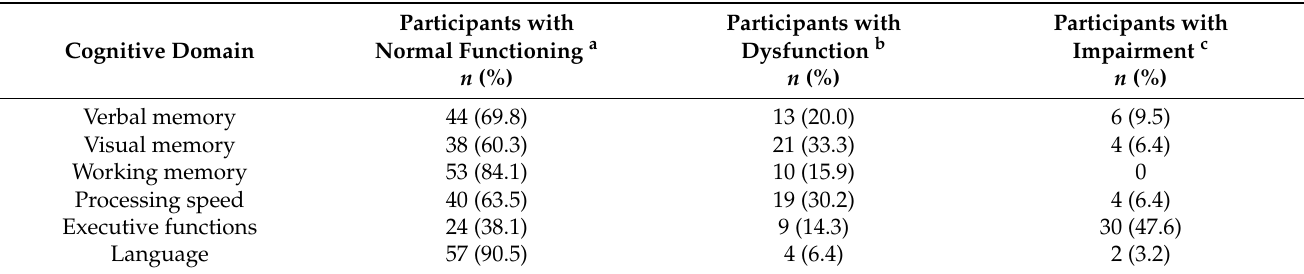
Table 4. Participants with prostate cancer who performed the neuropsychological assessment and presenting impairment in each cognitive